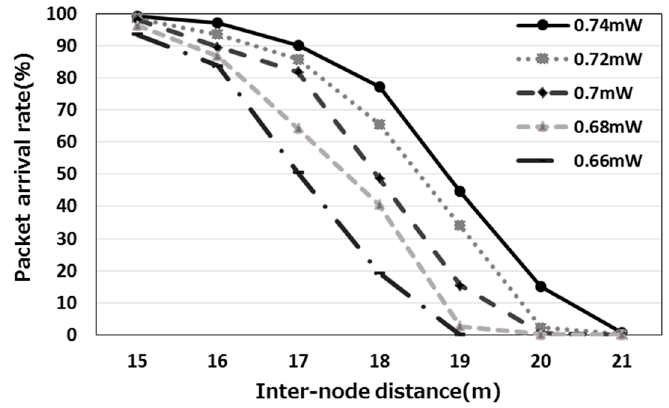
Figure 11. How the packet arrival rate varies with transmission power.